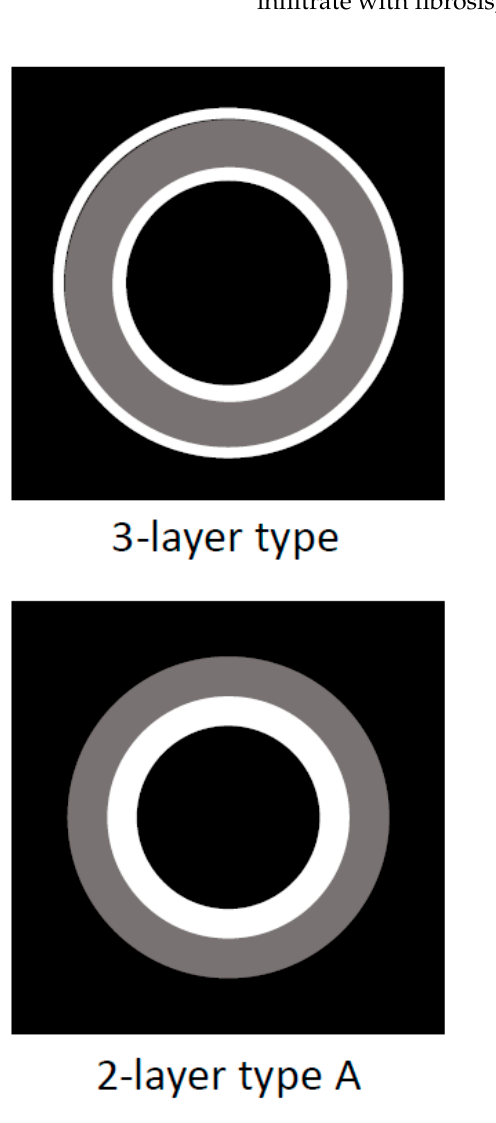
Figure 1. Schema of US/EUS findings in a diffuse type of IgG4-sclerosing cholecystitis. A diffuse type IgG4-CC could be classified into 3- or 2-layer type.